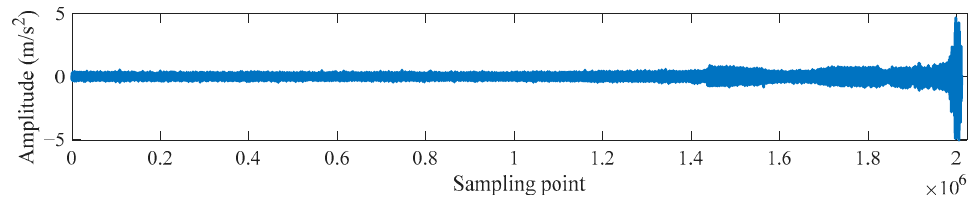
Figure 5. Bearing sampling signal.